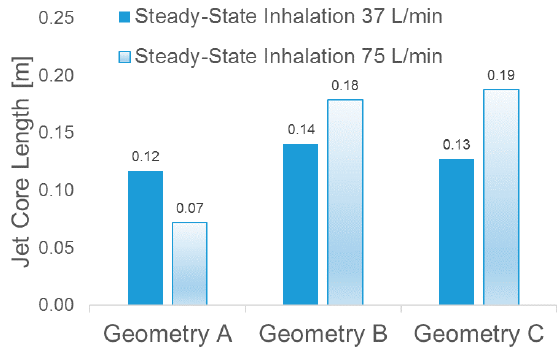
→ u (cid:107) / U in = 1.5 in the three geometries under two